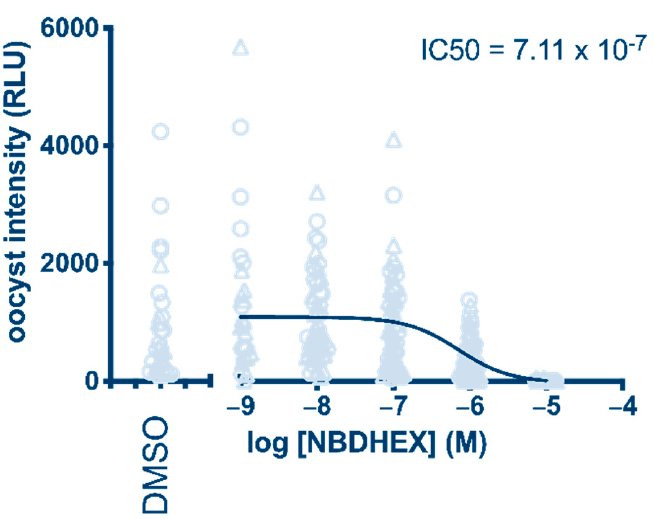
Figure 2. Determination of NBDHEX ( 1 ) transmission-blocking activity after 24 h treatment of P. falciparum gametocytes. Oocyst intensity is measured as relative light units (RLU) produced by the NF54- hsp70 -luc parasite line.